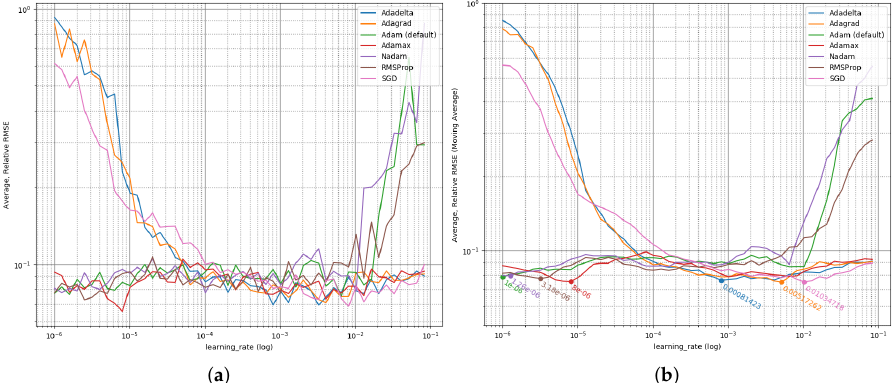
Figure 2. LR Optimization. MSE arr as prediction quality (( a ) normal, ( b ) moving average and marked minima) in dependence of LR s for 7 ML training algorithms, optimizing DFFNNs of fixed shape [Abbrevi-